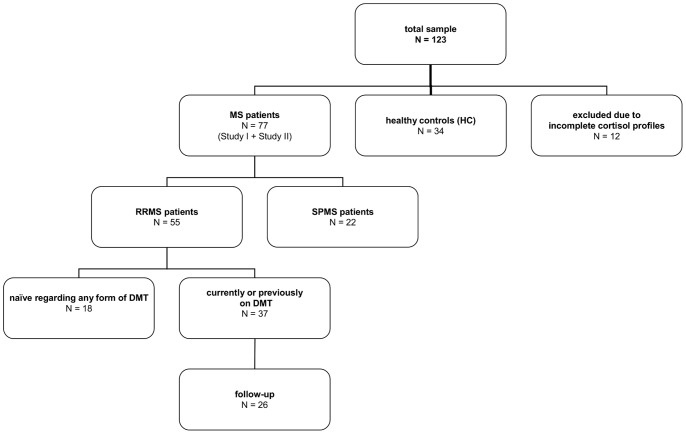
Sample description.